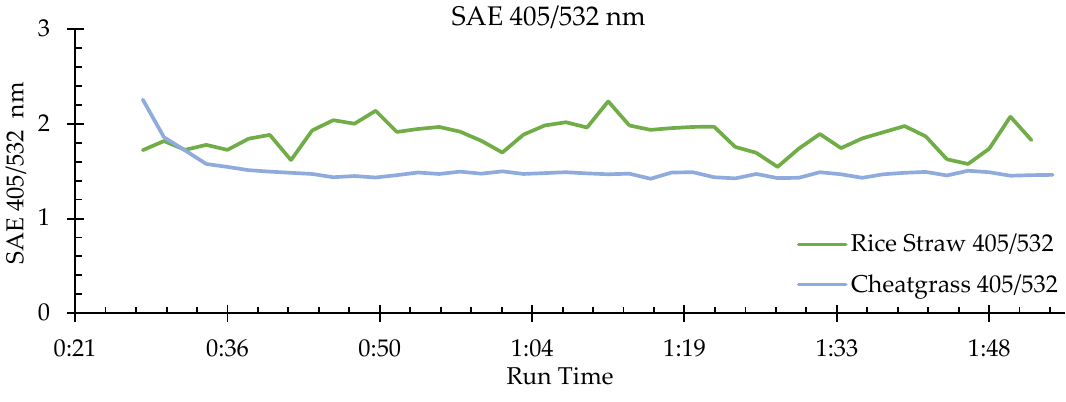
Figure 3. This plot is a comparison of the scattering Ångström exponents (SAE) for the 405 / 532 nm wavelength pair between one individual burn from the present study’s cheatgrass results with one individual burn of rice straw results determined from Lewis et al. [11]. Cheatgrass combustion emissions have a SAE range of 1.4–2.3 and rice straw combustion emissions have a SAE range of